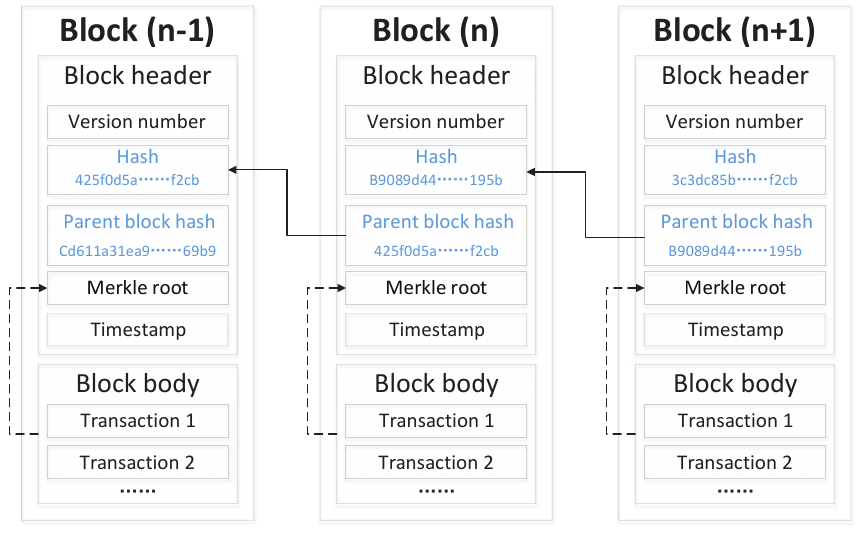
Figure 1. Blockchain